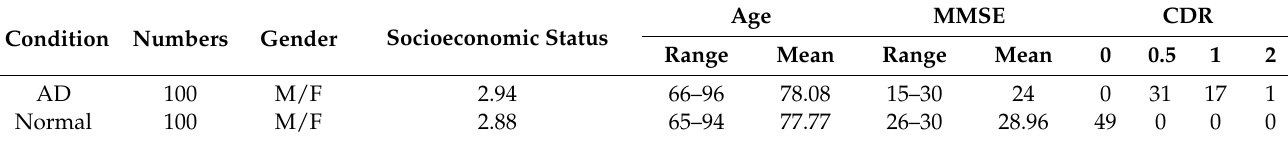
Figure 5. Example brain images of normal and AD subjects. Table 1. Subject demographics and dementia status.